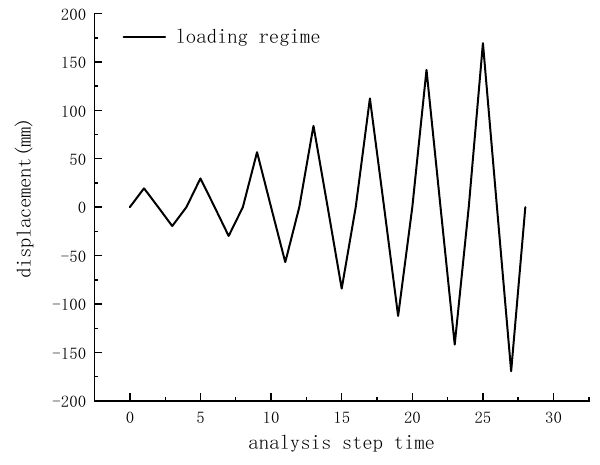
Figure 4. Horizontal loading regime.